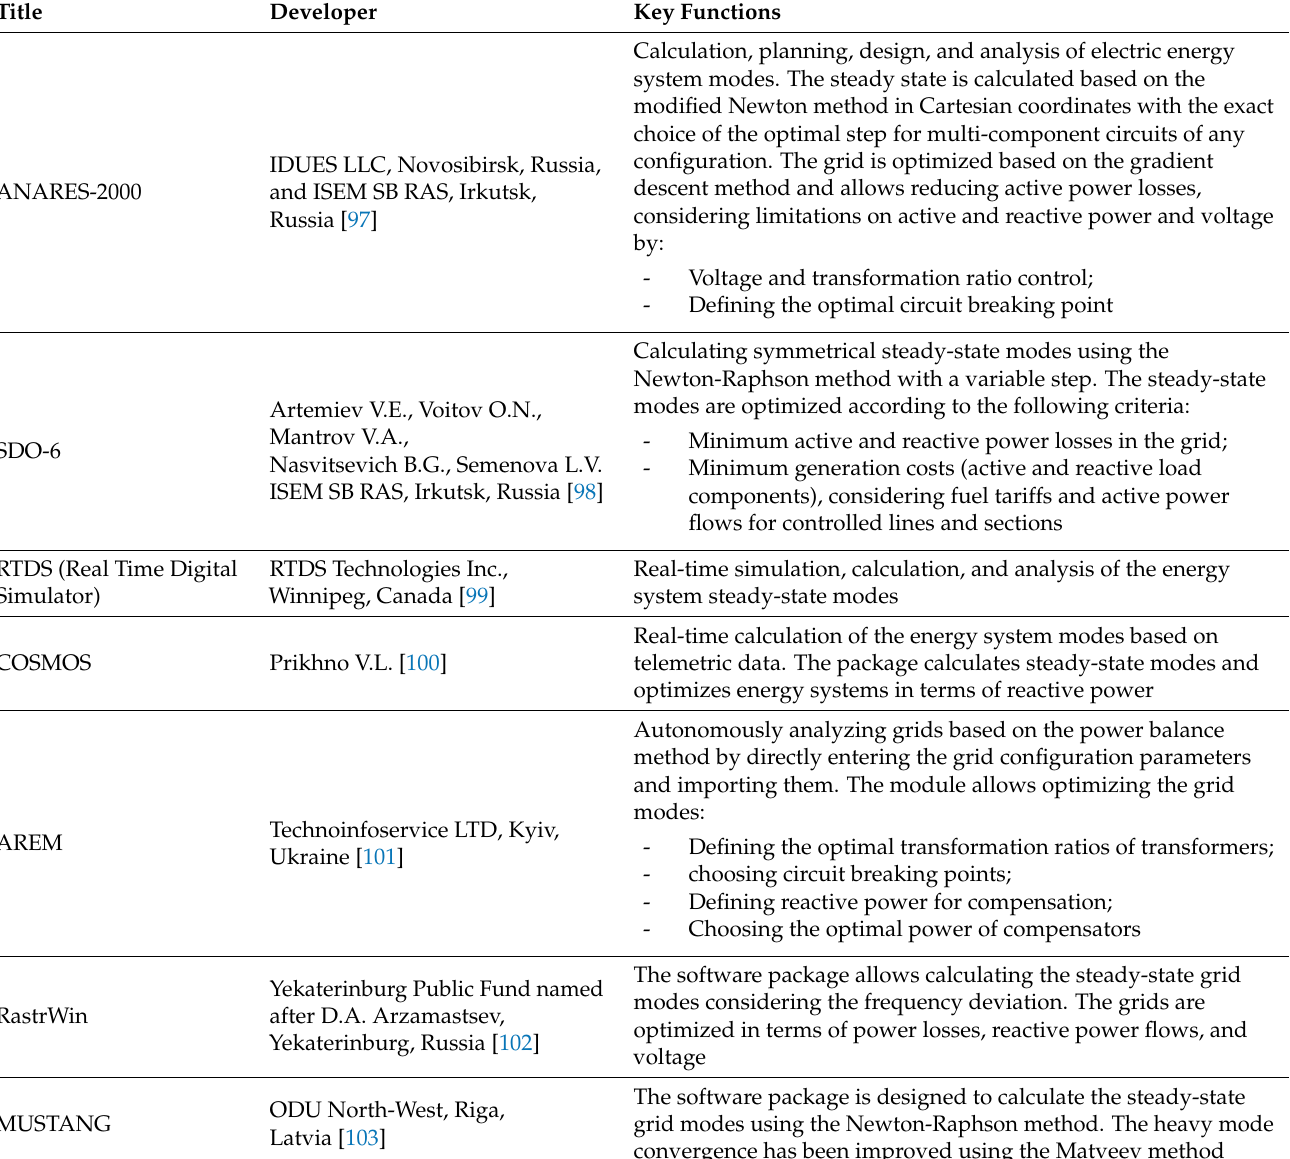
Table 2. Software products designed to calculate and optimize the electric energy system